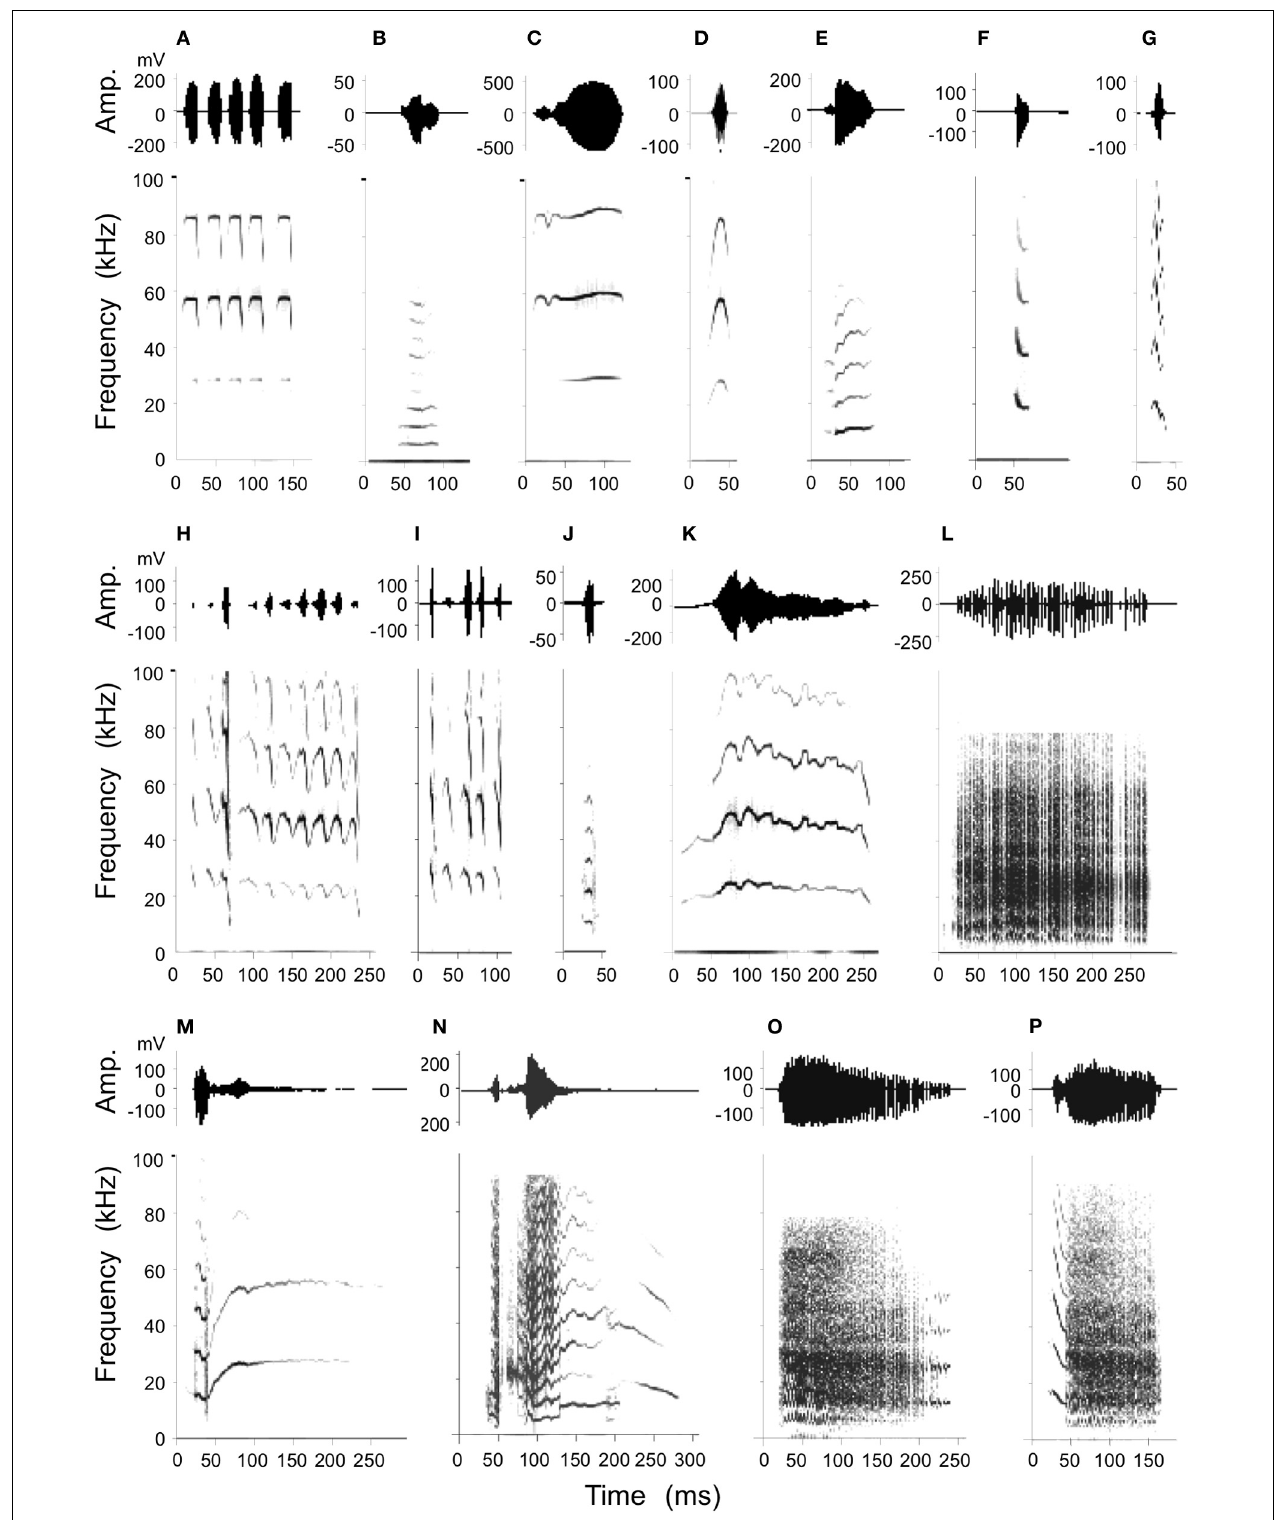
FIGURE 4 | Stimulation-elicited production of social calls including an example of echolocation pulses emitted at rest (A) for purposes of comparison. Amplitude envelops (top) and spectrograms (below) are shown for each example. Call types produced consisted of simple syllables as well as composites as follows: (B) : short Quasi CF (QCFs), (C) : short true CF